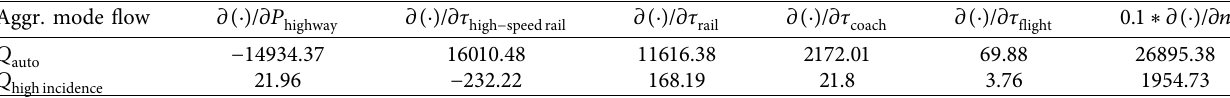
Table 16: Derivatives of the aggregated mode flows of auto as well as the aggregated demands of destination regions with high incidence rates with respect to different input